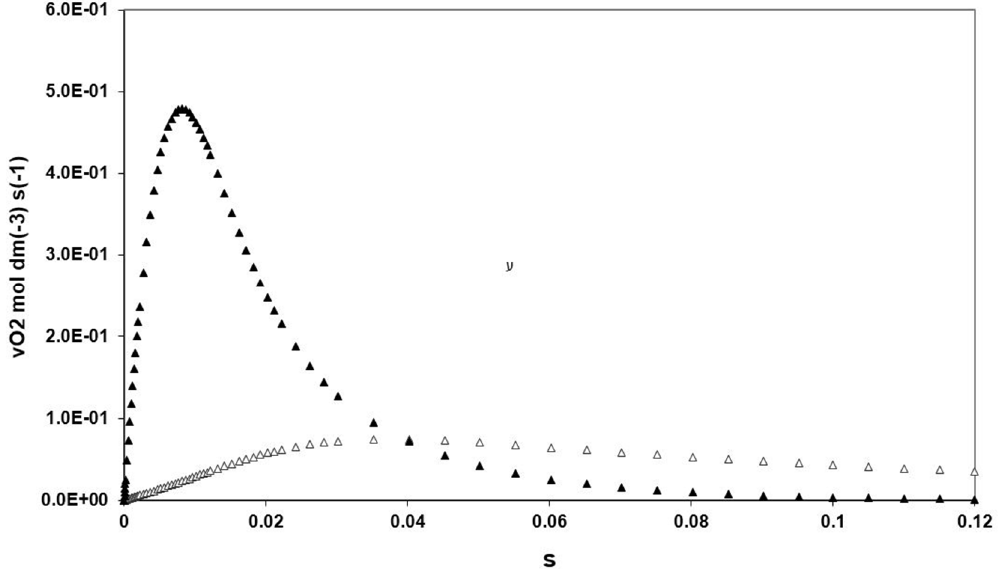
Figure 6. Rate of O 2 evolution in the early phase. [H 2 O 2 ] o = 0.5 mol dm − 3 (empty triangles); [H 2 O 2 ] o = 3.5 mol dm − 3 (full triangles). Other parameters as in Figure 2.